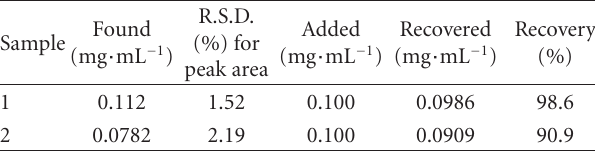
Table 1: The determination of atropine sulfate in patient urines ( n =